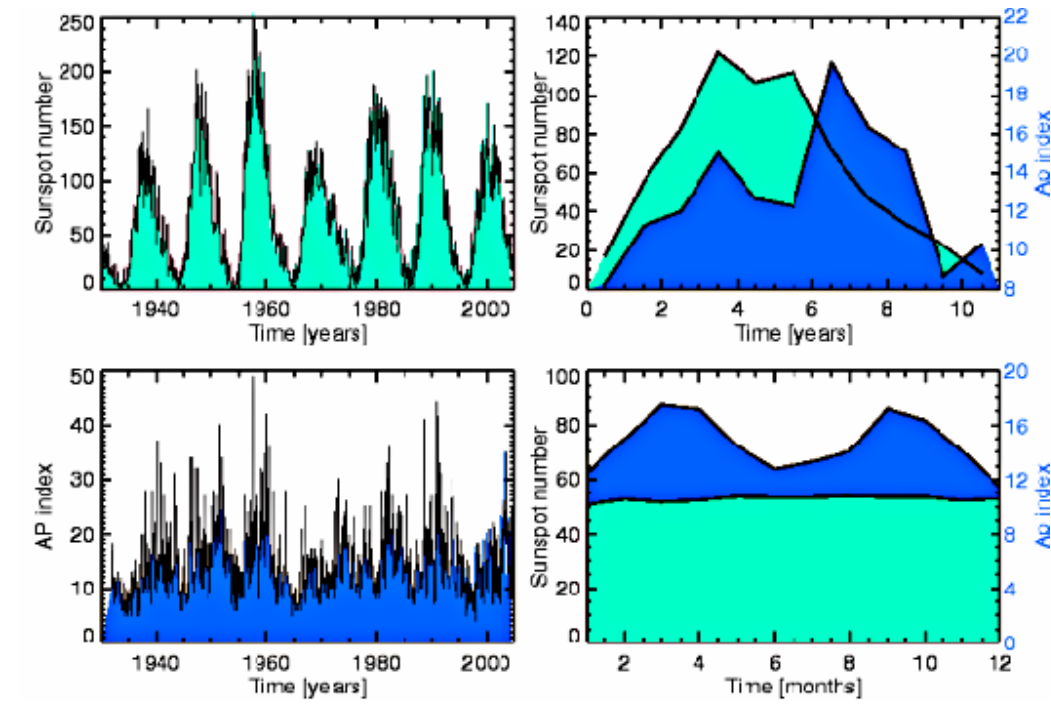
Figure 1. Periodicities in solar and geomagnetic activity. The left panels show time series of the monthly values of the sunspot number and the geomagnetic A panel shows the solar cycle variation present both in the geomagnetic and solar records, showing peak geomagnetic activity during the declining phase of the solar cycle. The bottom right panel shows the semiannual variation in the geomagnetic data not visible in the solar records. (From [26], reproduced by the kind permission of the author and the publisher. The source database: